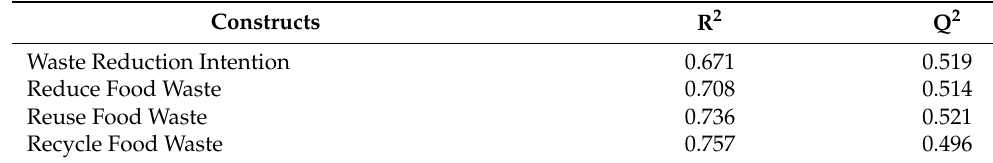
Table 5. Coefficient of determination (R 2 ) and Q 2 .